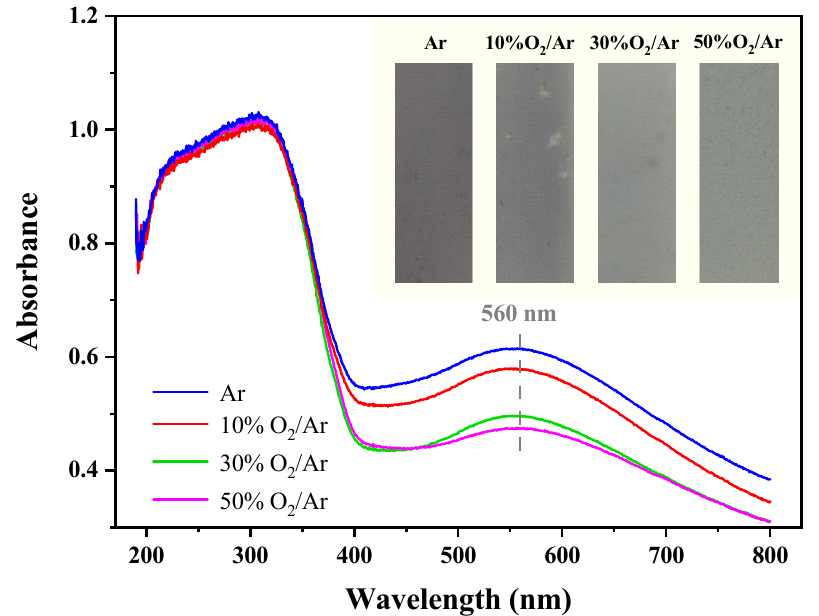
Figure 5. UV-vis DRS of Au/TiO 2 samples activated by Ar plasma, 10% O 2 /Ar, 30% O 2 /Ar and 50% O 2 /Ar plasmas. Inset photos of Au/TiO 2 samples activated at various O 2 contents.